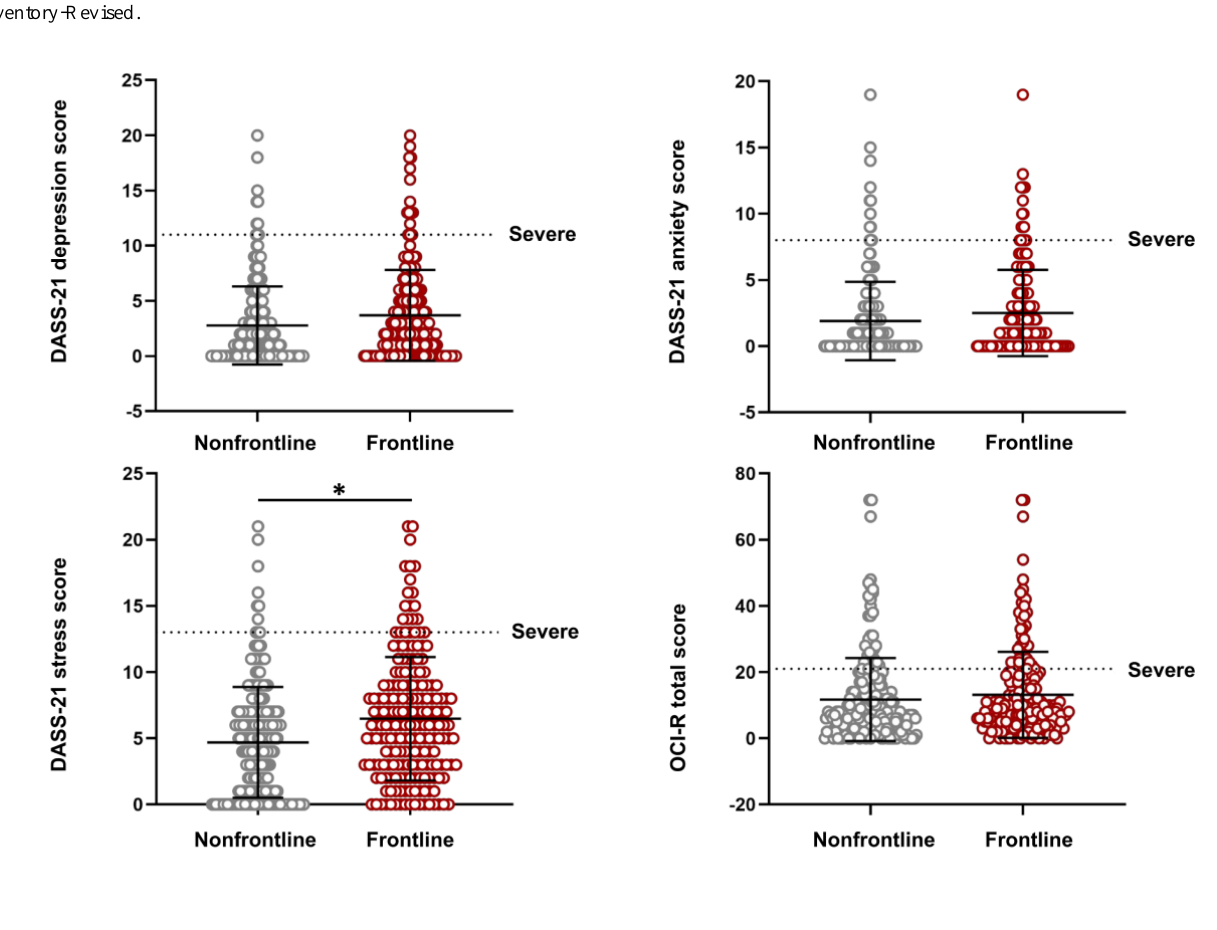
Figure 1. DASS-21 and OCI-R scores of frontline (n=200) and nonfrontline (n=220) Portuguese physicians during the COVID-19 pandemic (May 4-25, 2020). Lines represent mean (SD) values. Points above the dotted line represent participants with severe symptoms. *Statistically significant differences between nonfrontline and frontline groups. DASS-21: 21-items Depression, Anxiety, and Stress Scale; OCI-R: Obsessive-Compulsive Inventory-Revised.